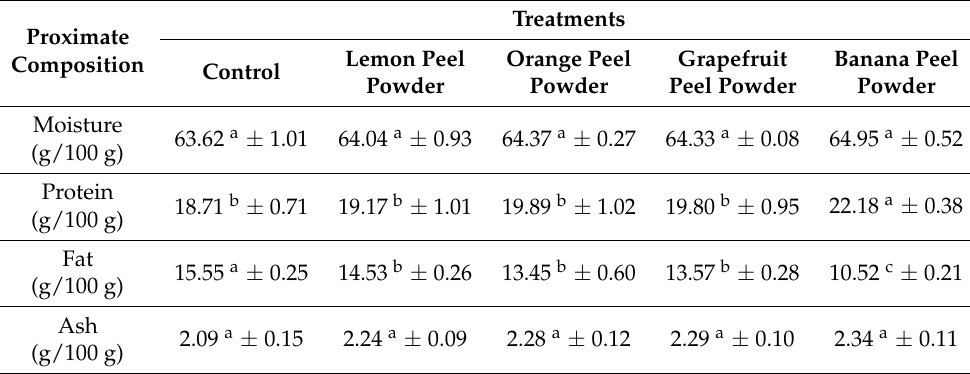
Table 1. Results of the compositional analysis of chicken patties treated with different fruit peel powders at a concentration of